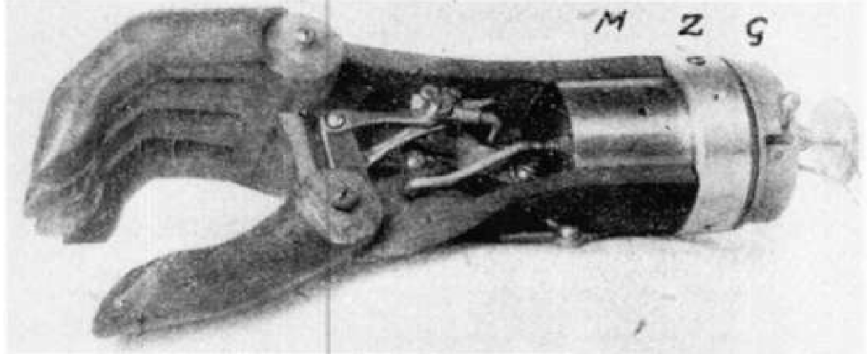
Figure 1. Photograph of the first electric powered myoelectric prosthetic hand used by the inventor Reinhold Reiter (Circa 1943). Reprinted with permission from